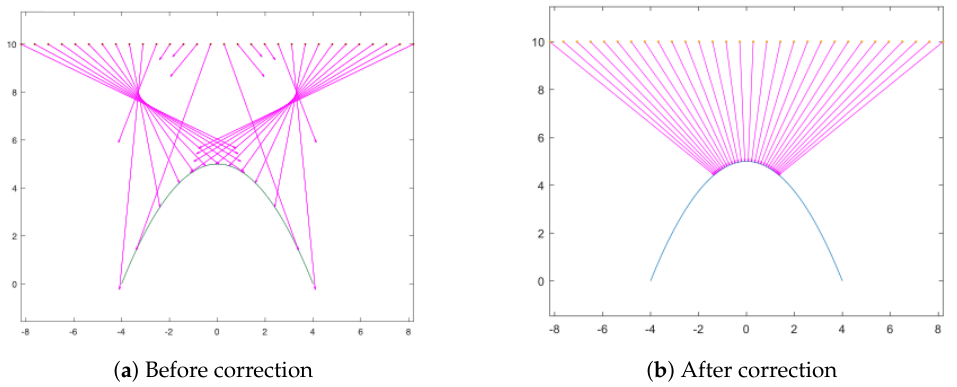
Figure 11. Second-order algebraic point projection with test points at a far distance: ( a ) using non-corrected normal vector; and ( b ) using corrected normal